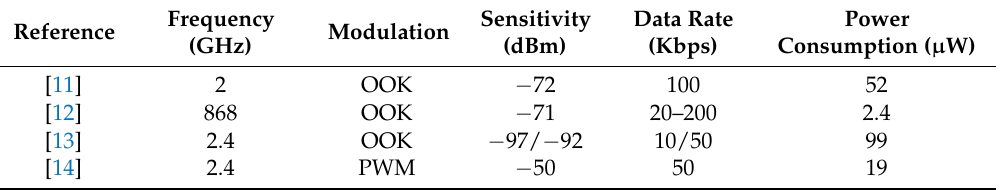
Table 1. Propertiesofdevelopedwake-upreceivers. OOK=On-OffKeying. PWM=PulseWidthModulation. Frequency Sensitivity Data Rate Reference Modulation (GHz) (dBm)